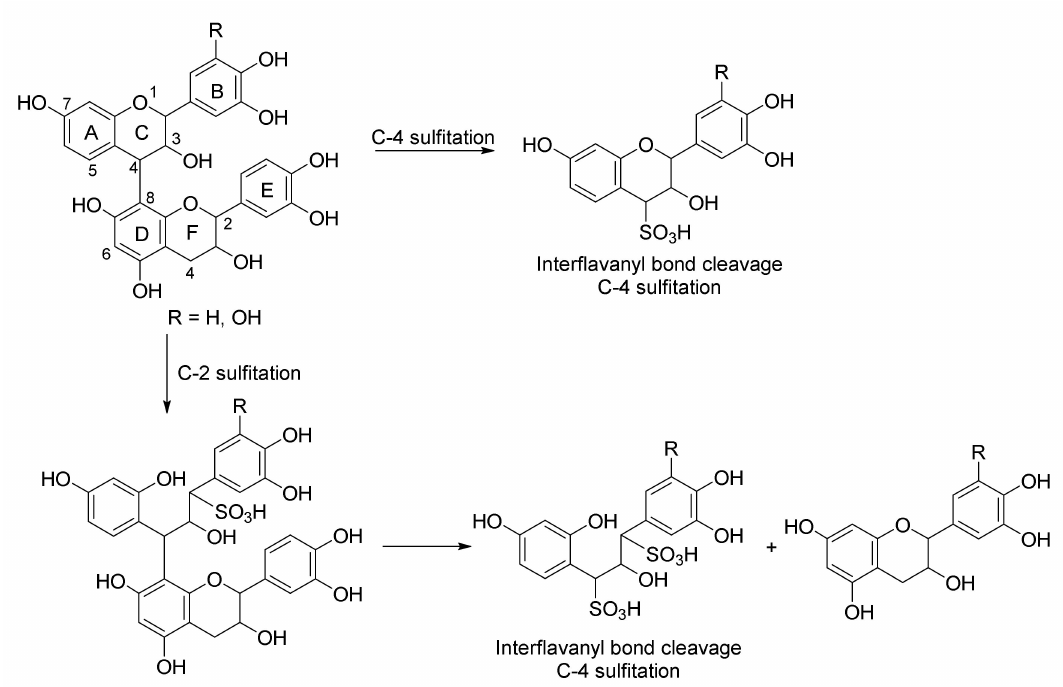
Figure 3. Sulfitation of a PAC dimer a ff ords C-2 and C-4 (interflavanyl bond fission) sulfonated